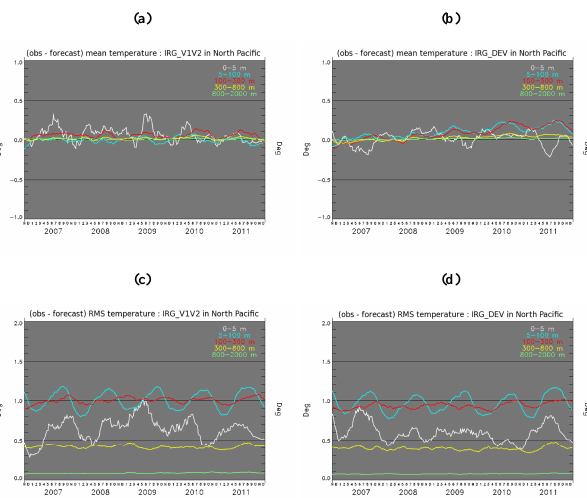
Fig. 18. Temperature data assimilation statistics in the North Pacific GODAE region, and for IRG_V1V2 ( a and c ) and IRG_DEV ( b and d ): Mean ( a and b ) and RMS ( c and d ) of temperature (°C) innovations (observation minus forecast) computed in layers (0-5, 5-100, 100-300, 300-800, 800-2000) and as a function of time during the 2007-2011 period. For clarity, the time series were smoothed with a 60-day running mean. These scores are averaged over all seven days of the data assimilation window, with a lead time equal to 3.5 days.